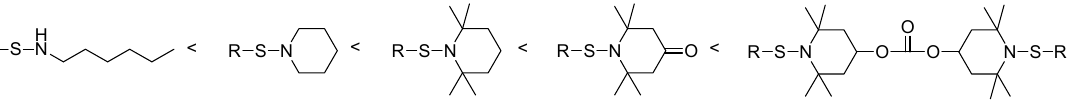
Scheme 2. Substituent effect on thermal stability of sulfenamide compounds.